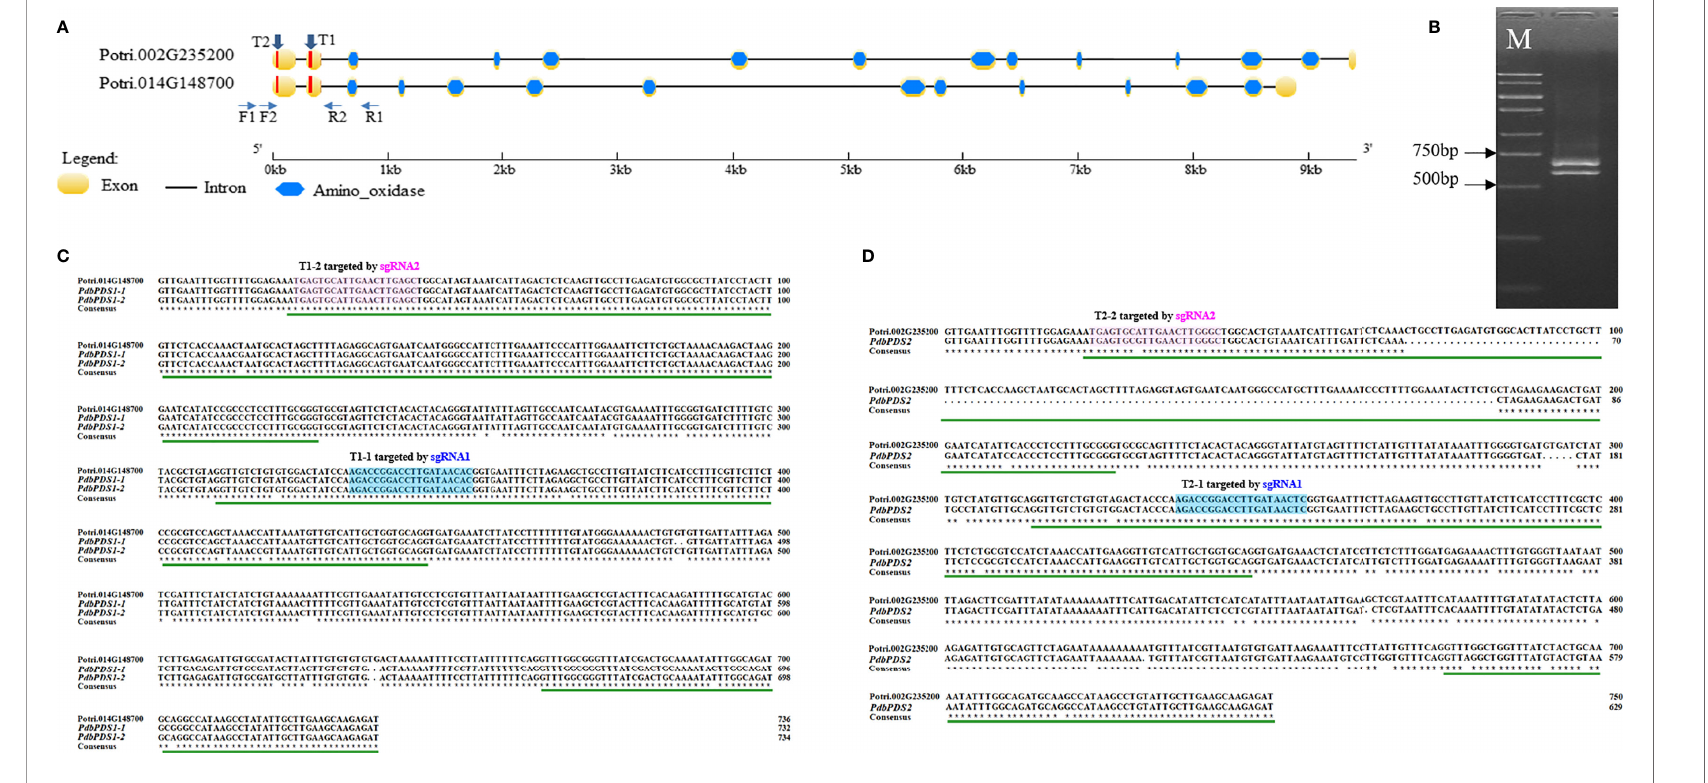
FIGURE 1 | Targets locations and sequence alignments. (A) Structures of PtPDS genes in P. trichocarpa . T1 and T2 indicate the targets locations. F1 and R1 were used to amplify Shanxin yang PDS genes fragments. F2 and R2 were used to amplify the target region. (B) PCR ampli fi cation of PdbPDS genes fragments. (C) Alignment of two PdbPDS1 allele fragments and Potri.014G148700. (D) Alignment of one PdbPDS2 allele fragment and Potri.002G235200. In (C , D) , the green lines below aligned sequences indicate predicted exons within the ampli fi ed fragments; and the blue and pink boxes represent potential target sites that may be bind by sgRNA1 and sgRNA2, respectively. The fi rst number in each target name represents the gene number, while the second number represents the number of sgRNA, e.g., T1-1 means the target site in PdbPDS1 that can be bounded by